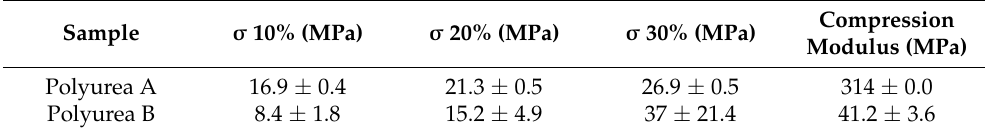
Table 4. Compression test